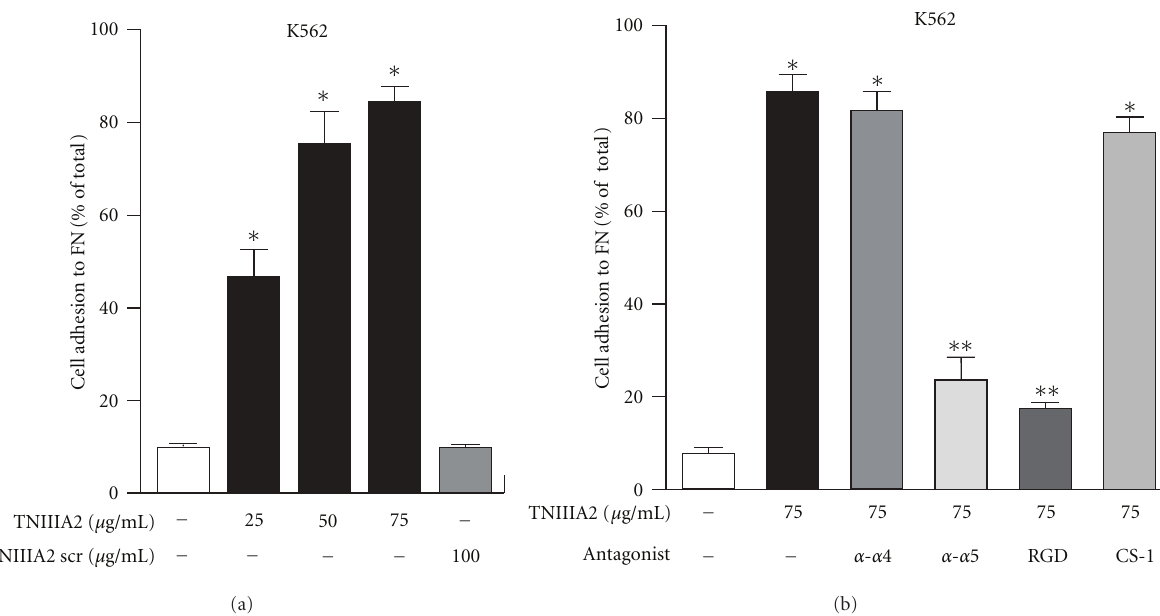
Figure 4: Adhesion of K562 cells to FN through α 5 β 1 integrin activation. (a) Dose dependency of TNIIIA2-induced adhesion of K562 cells. (b) E ff ects of antagonist for VLA5 ( α - α 5 Ab and RGD) and VLA4 ( α - α 4 Ab and CS-1) on TNIIIA2-induced adhesion to FN in K562 cells (figures were modified from Figure 1 of [45]). ∗ P < 0 . 05 versus untreated control, ∗∗ P < 0 . 05 versus TNIIIA2 single treated sample.